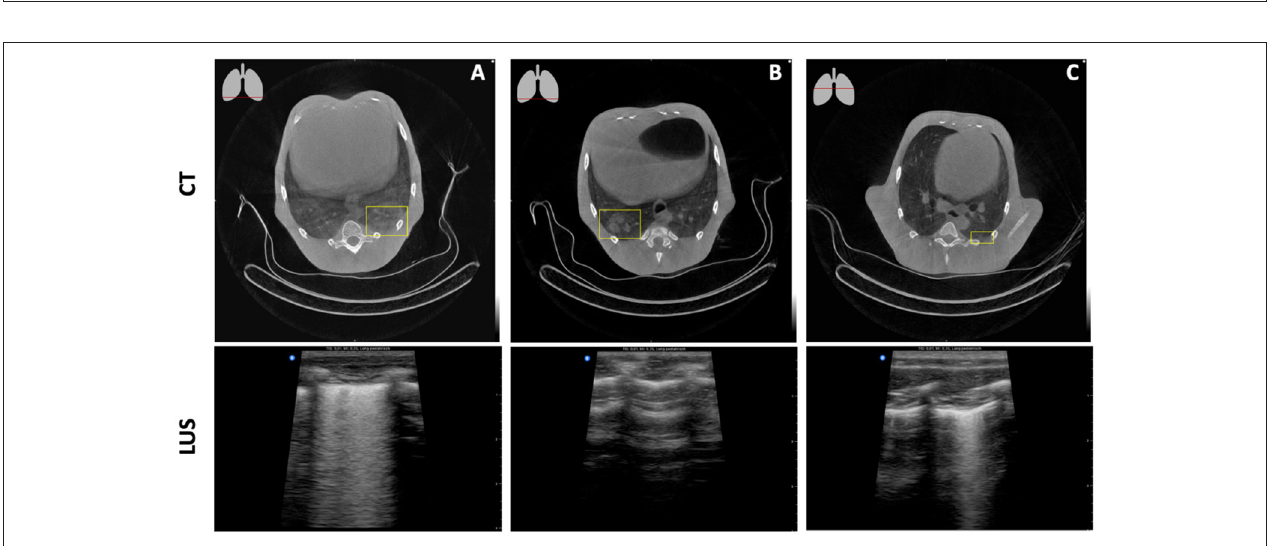
FIGURE 5 | Longitudinal assessments of a peripheral focal nodular lesion after SARS-CoV-2 infection in the lower-right plane. D0, obtained pre-infection showed no aberrations both on CT and LUS. From D2 onwards, on CT (upper row) this minor consolidation was observed at the ventral side of the pleural wall in the right middle lobe. The lesion was detected in the lower right quadrant on the anterior pleural wall, corresponding with the R2 area on LUS (bottom row) leading to multifocal B-lines on D2, singular B-lines on D14, and a combination of both on D7.